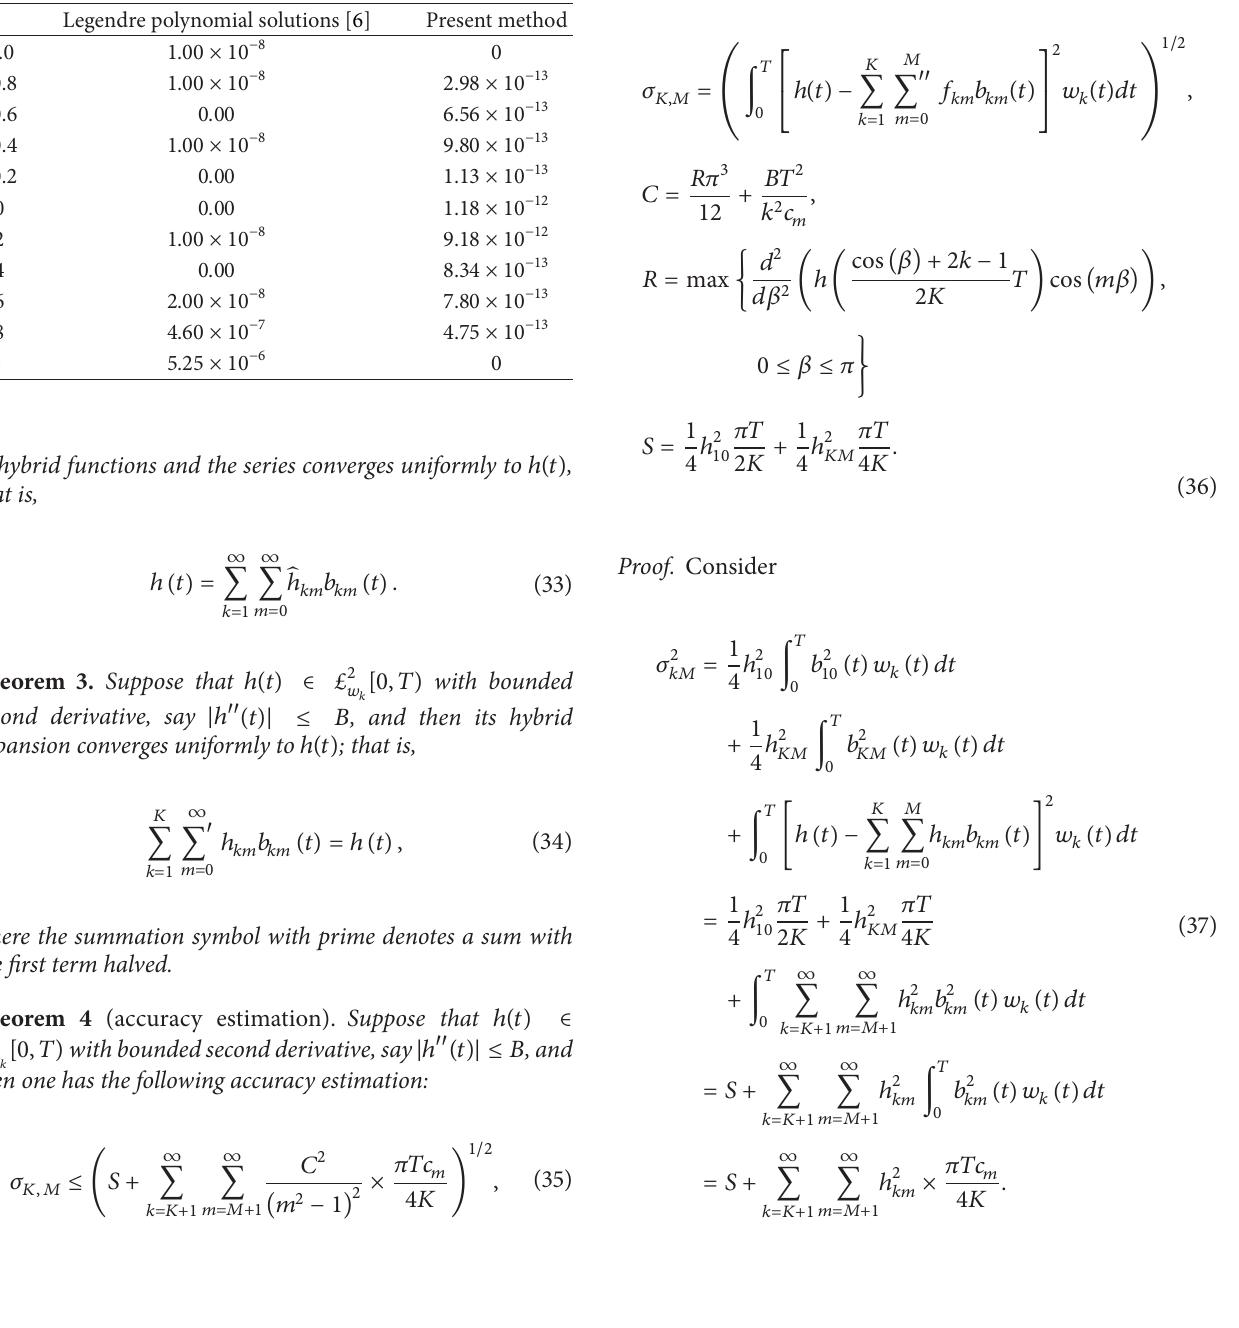
Table 8: A comparison of absolute errors between Lps and